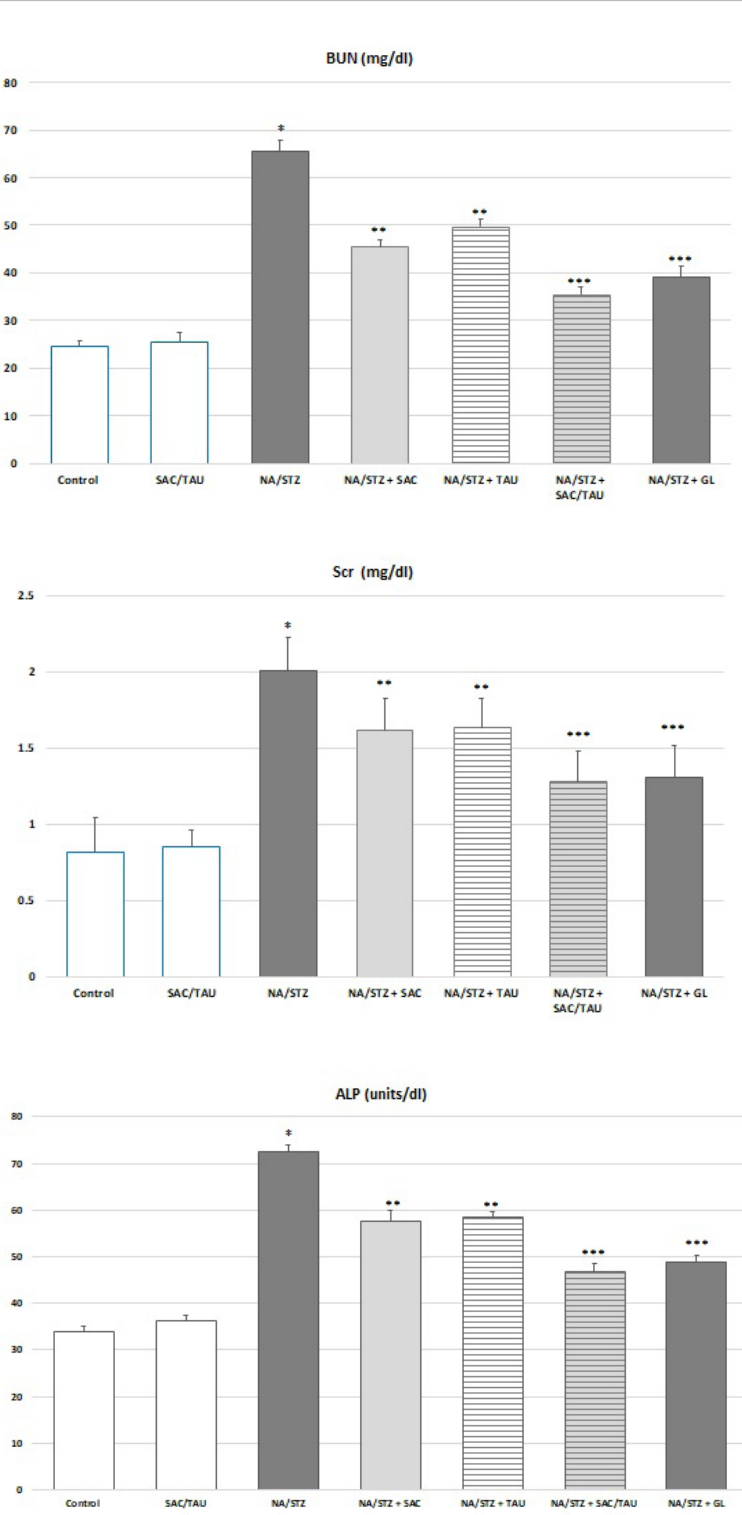
FIGURE 1 - Effect of SAC, TAU and SAC/TAU treatment on conventional markers of renal integrity. NA/STZ group showed a significant increase in ( A ) BUN, (B) Scr and ( C) ALP in serum samples. SAC, TAU and GL treatment preserved the marker levels with the highest effect detected with SAC/TAU combination. Values are expressed as mean ± S.E.M. *P<0.05 diabetic (NA/STZ) group vs. control OR SAC/TAU group. **P<0.05, ***P<0.01.NA/STZ+SAC, NA/STZ+TAU and NA/STZ+SAC/TAU group vs. diabetic (NA/STZ)